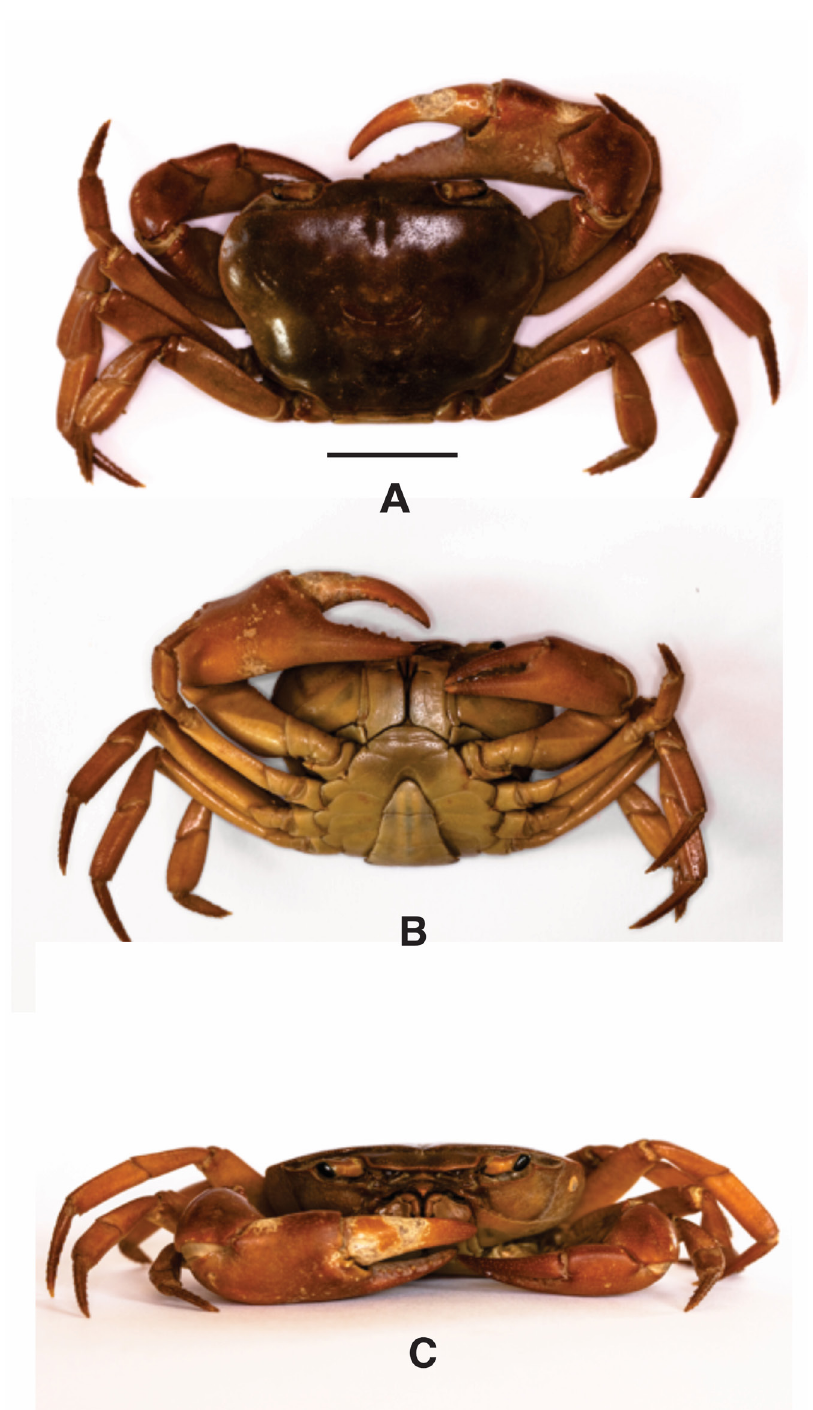
Fig. 7. Potamonautes baziya sp. nov., ♂, holotype (CL = 29.28 mm) (SAM A-094474). A . Entire animal, dorsal aspect. B . Entire animal, ventral aspect. C . Cephalothorax, frontal aspect. Scale bar = 10